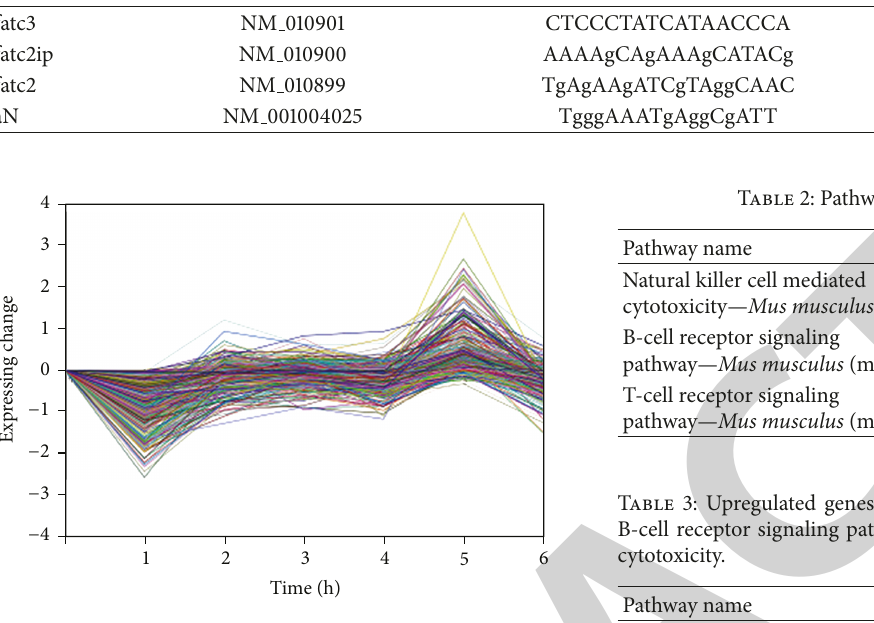
Figure 1: Expressing change of genes covered in NO.21 at 6 time points.